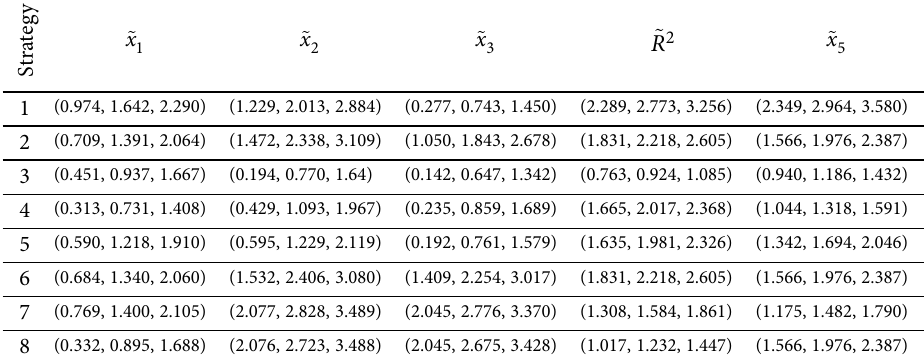
Table 7. Aggregated decision